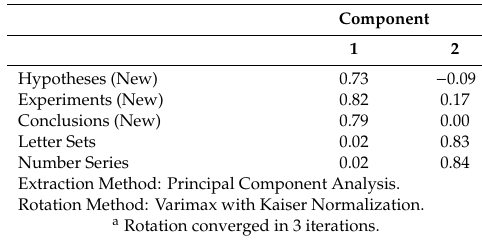
Table 3. Study 1. Rotated principal-components matrix: New measures plus fluid-intelligence tests a .